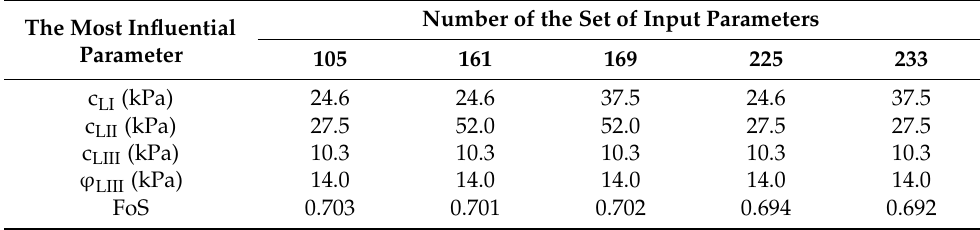
Table 5. The sets of the most influential input parameters for FoS from 0.69 to 0.70.